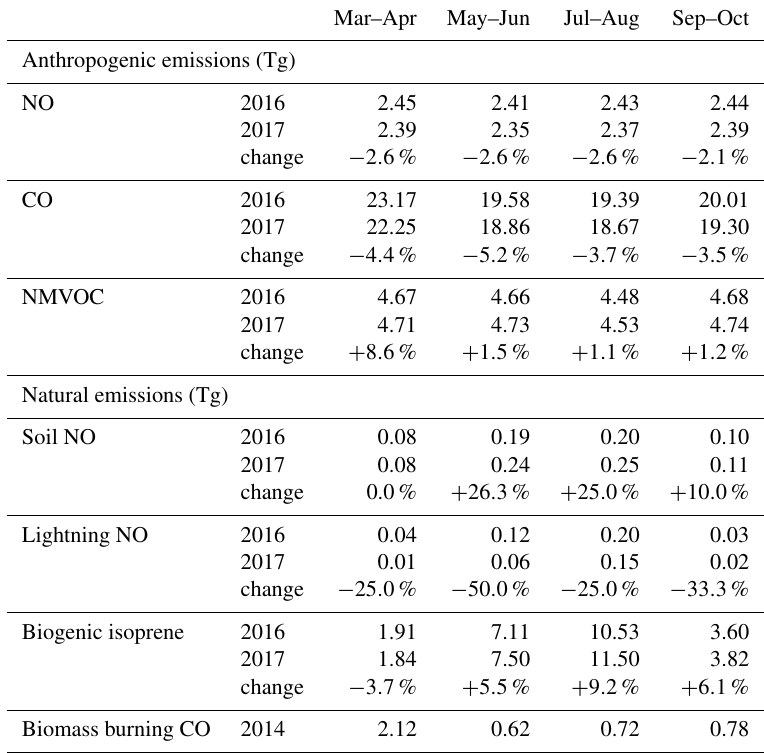
Table 2. Bimonthly mean anthropogenic and natural sources over China used in the